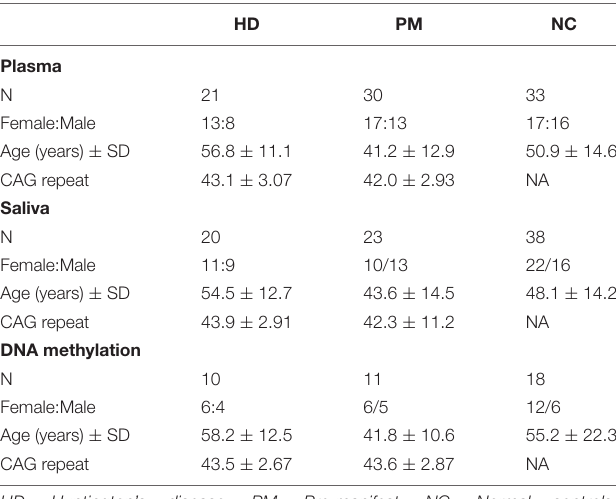
TABLE 1 | Characterization of cases included in this